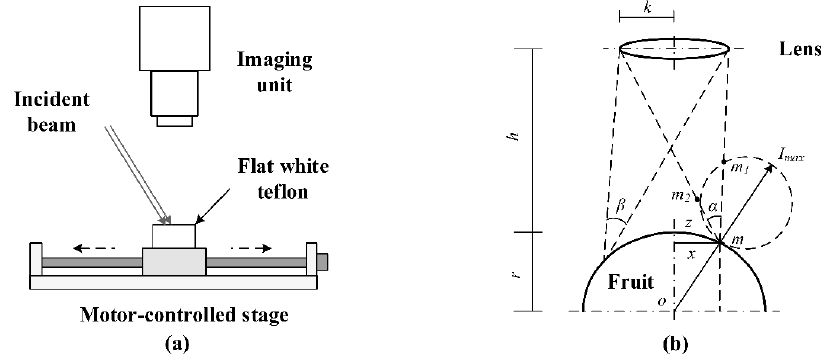
Figure 11. Correction of scattering images for ( a ) the uneven instrumental responses and ( b ) the fruit surface curvature.